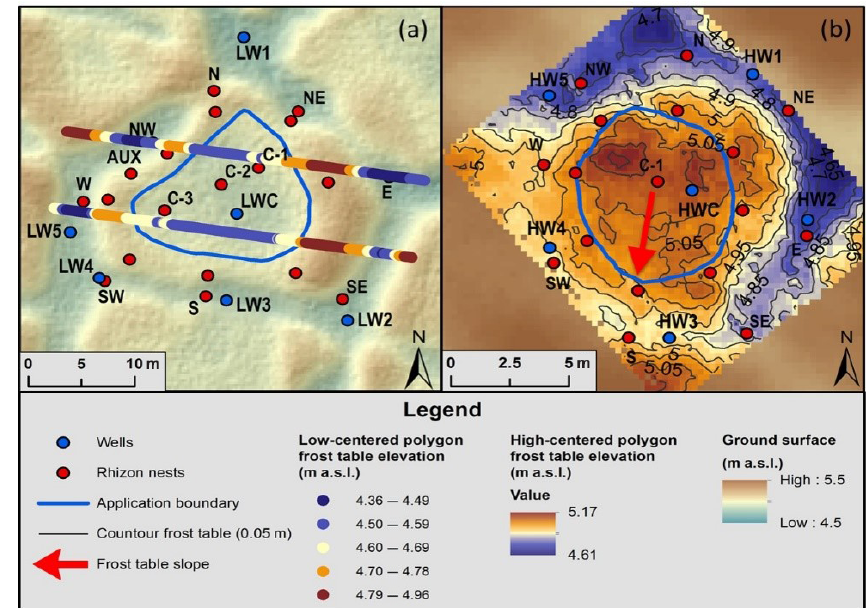
Figure 8. Frost table elevation obtained with a ground-penetrating radar survey at the (a) the low-centered and (b) high-centered polygon locations. Note that transect lines indicate frost table elevation at the low-centered polygon (a) while topographic lines indicate frost table elevation at the high-centered polygon (b) . Red arrow indicates the direction of frost table slope in high-centered polygon. Widths of transects on low-centered polygon exaggerated for legibility. See Supplement, Tables S2 and S3 for frost table depths.